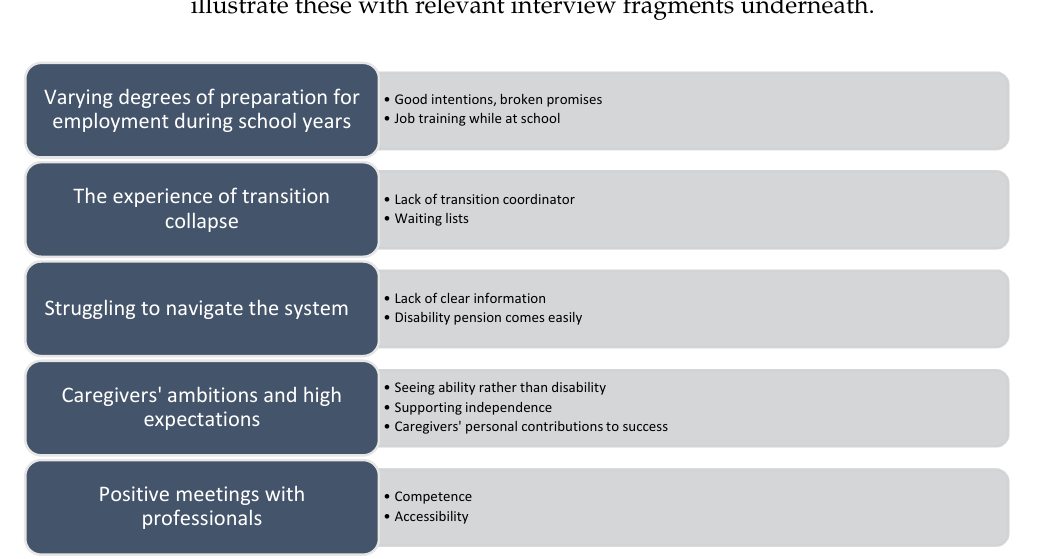
Figure 1. Main themes and subthemes in the data set.